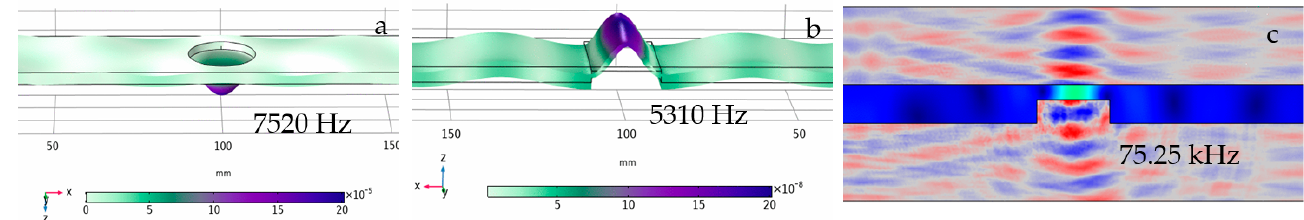
Figure 1. ( a – c ): FEM simulation of resonant behaviour of FBH: LDR for a circular ( a ) and rectangular ( b ) FBH in polymethyl methacrylate (PMMA); ( c ) RACE for rectangular FBH in an aluminium plate.